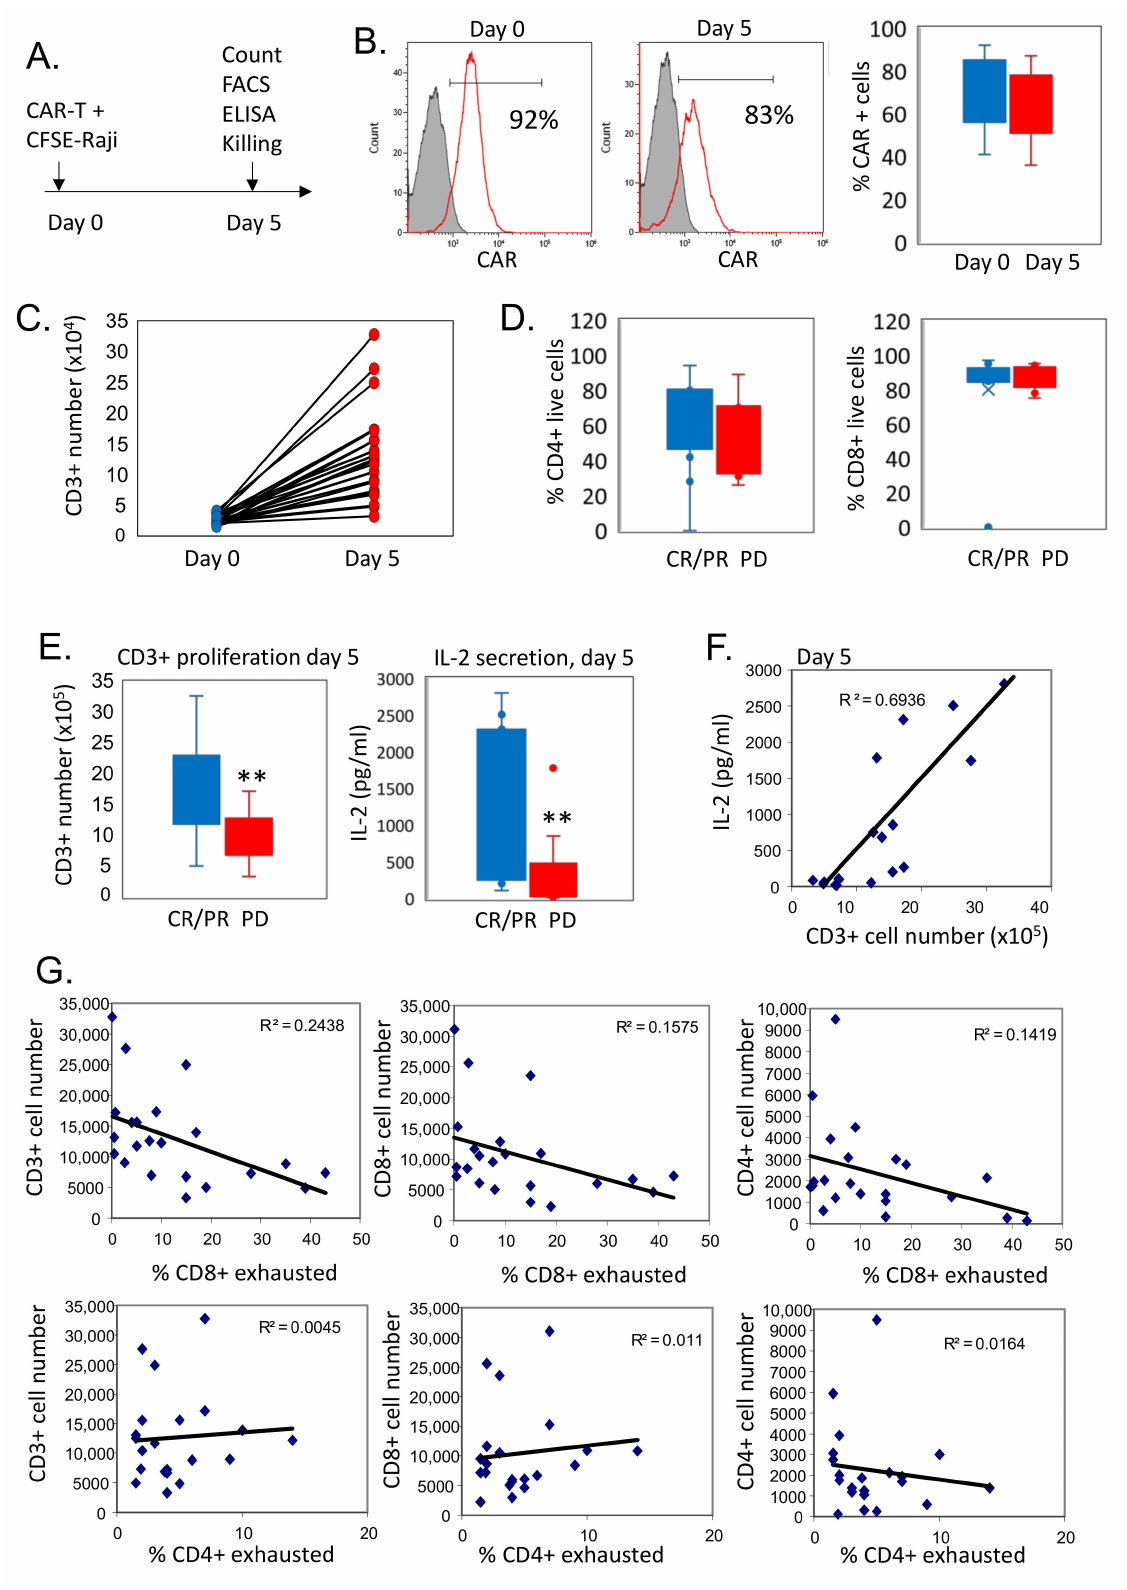
Figure 4. CAR T cell proliferative capacity and IL-2 secretion correlate with therapeutic response. ( A ) Schematic representation of co-culture experiment with CAR T cells and CFSE-labeled target